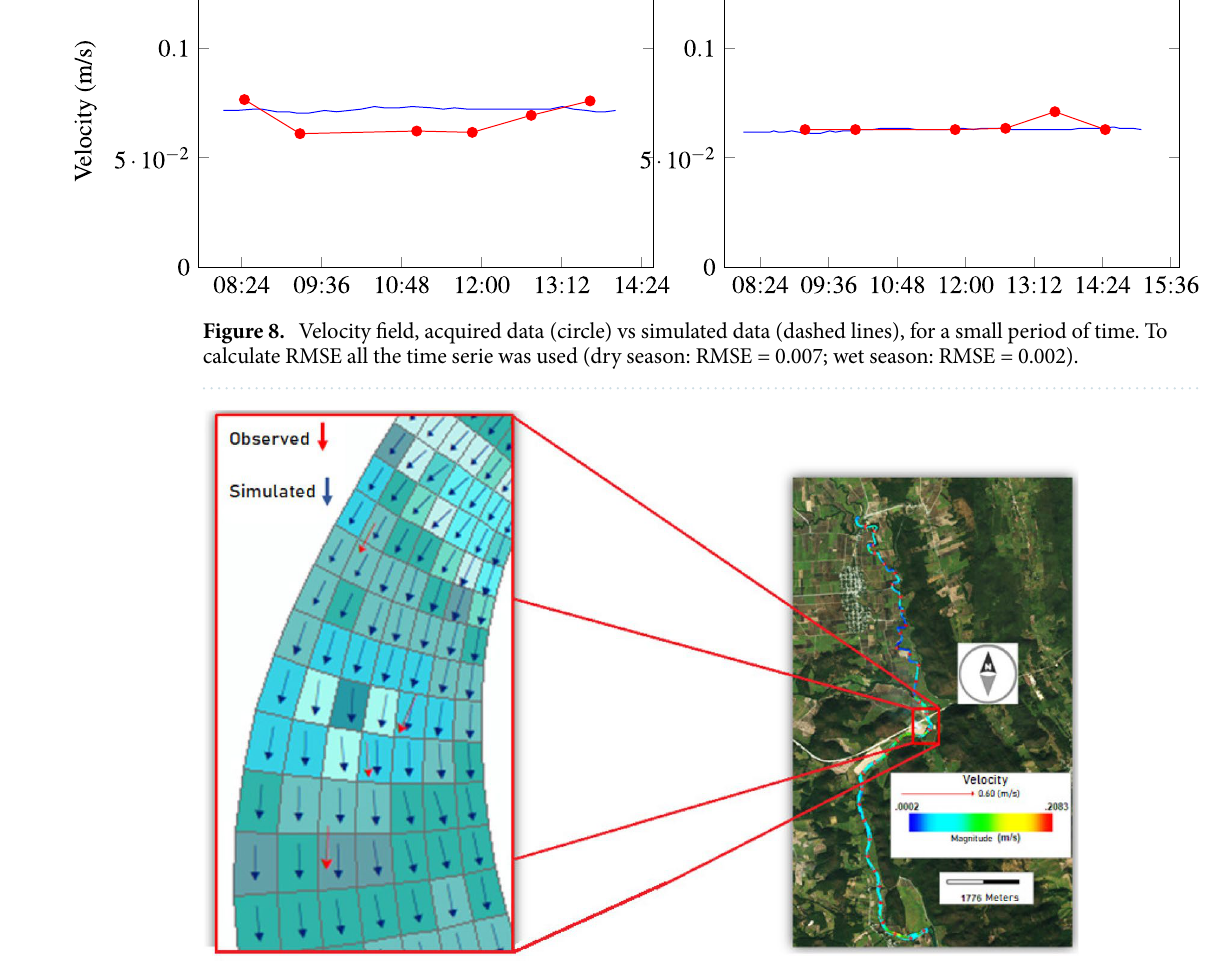
Figure 9. Velocity vectors, red (measured) vs blue (modeled), the fit is satisfactory in terms of magnitude and direction. This figure was generated with ArcGis 10.5 (https:// deskt op. arcgis. com/